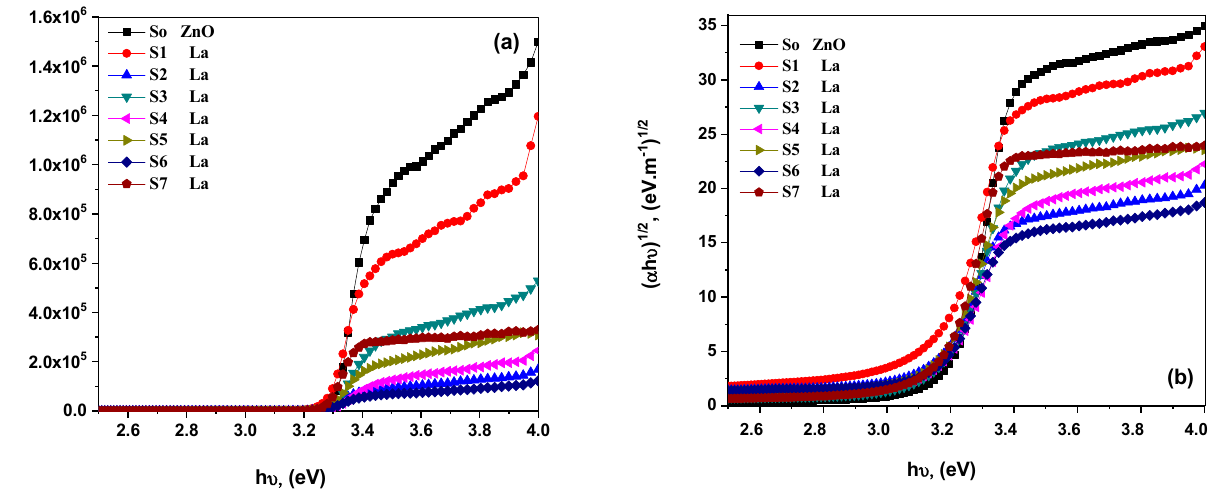
Figure 4. ( a , b ): ( a ) direct transition ( α h υ ) 2 , ( b ) indirect transition ( α h υ ) 1/2 versus the photon energy ( h υ ) of the as-prepared La 2 O 3 -doped ZnO nanostructures. Table 3. Direct and indirect transitions of as-prepared La 2 O 3 -ZnO nanostructures.